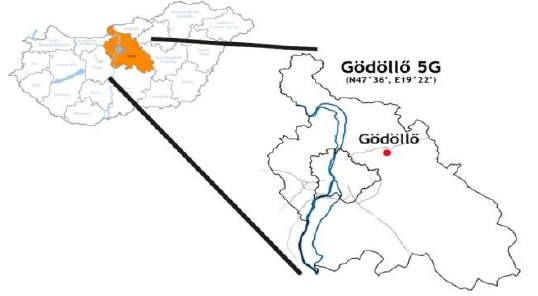
Figure 1. Location of the study site